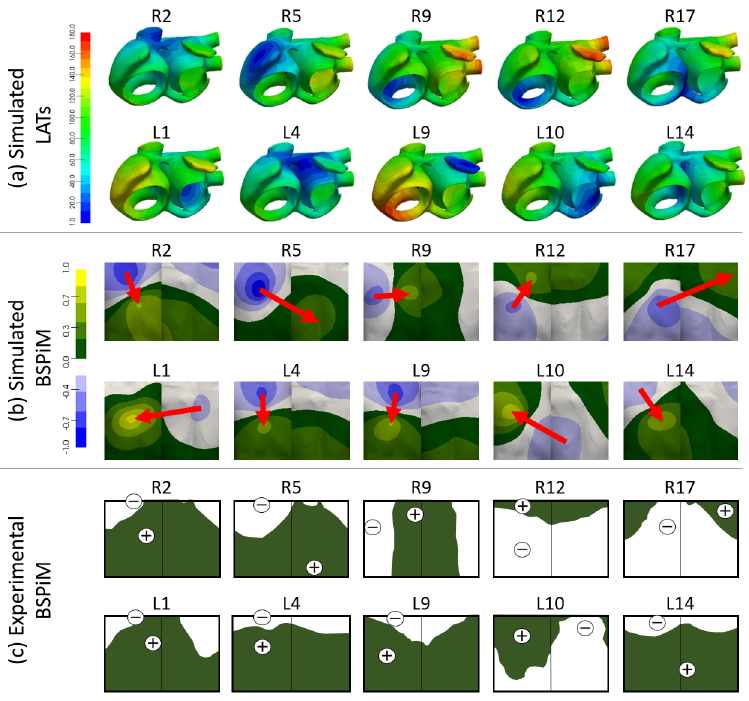
Fig 4. Comparison between simulated and experimental BSPiMs. (a) SimulatedLocal Activation Times (LATs) computed when the ectopic sites are locatedat different positionsof the RA (2, 5, 9, 12 and 17) as definedin [8] and locationsof the LA (1, 4, 9, 10 and 14) as definedin [10,11].Bluish colour corresponds to t = 0 ms and reddish colourscorrespondto the latest activationtime. Time is given in milliseconds; (b) Simulated normalized BSPiM computedat the 14.157nodes of the torso surface for each ectopic focus. Bluish colourscorrespond to the most negativewhile yellowishcorrespond to the most positive integral values. Red arrows represent the position of the minima towards maxima integralvalues; (c) Experimental integralpatterns reproducedfrom the originalspublishedby SippensGroenewegen et al in [8–11].White colour means negativeintegrals(equivalent to the blueishrange for the simulatedBSPiM) while green colour means positive integrals(equivalent to the greenishto yellowishrange for the simulatedBSPiM).